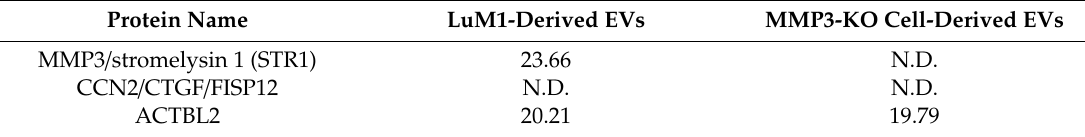
Table 3. Protein MS / MS scores of EV fractions derived from LuM1 vs MMP3-KO